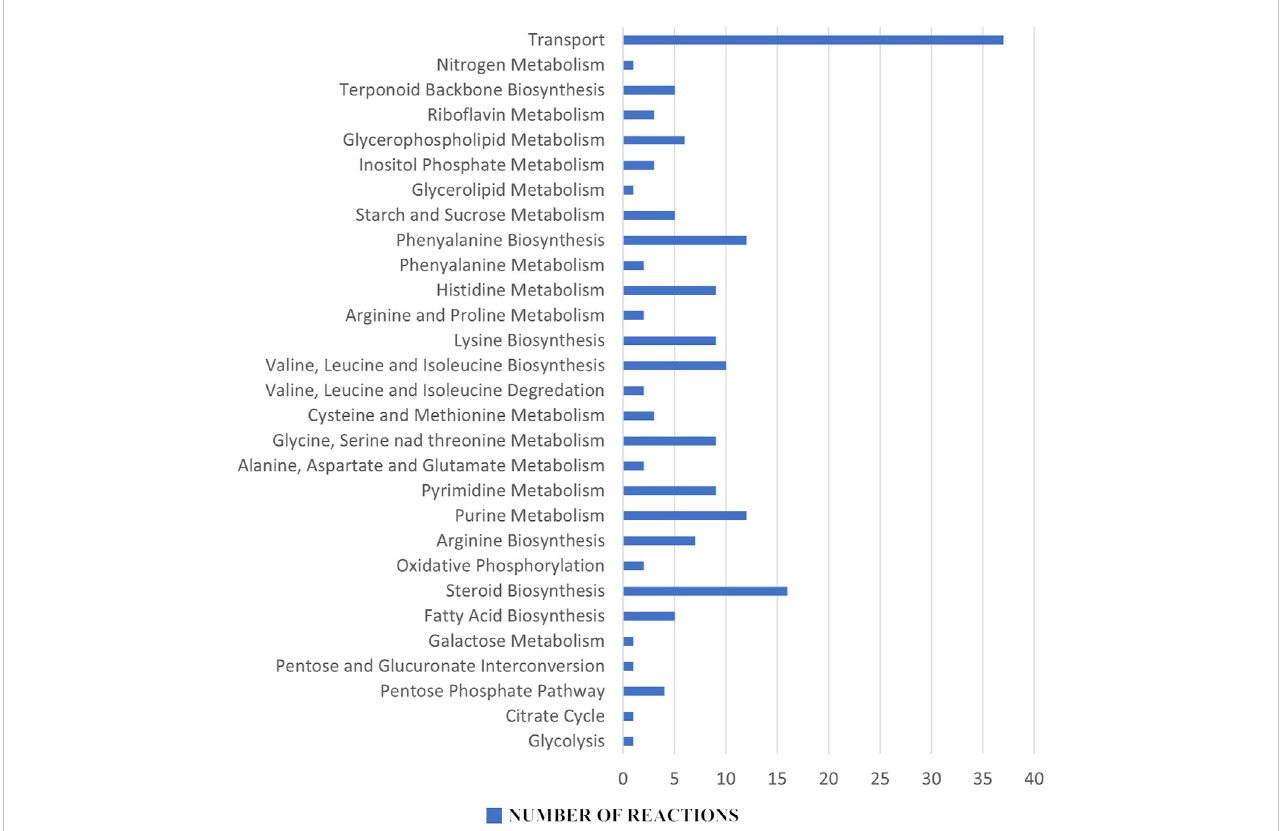
FIGURE 4 Essential reaction distribution: Among the 198 essential reactions, purine and pyrimidine metabolisms, amino acid metabolism, fatty acid biosynthesis and steroid biosynthesis all stand out as potential pharmacological targets for the next therapeutic